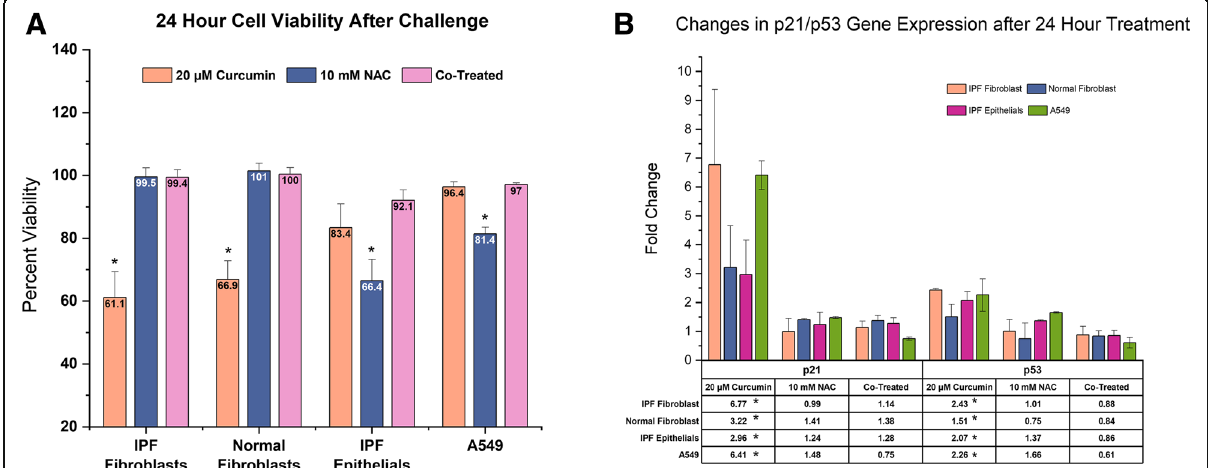
Fig. 5 Epithelial and fibroblast cell viability and DNA damage response gene expression after 24-h challenge: ( a ) 20 μ M curcumin treatment induces reduced viability in IPF-F ( n = 4) and NHLF ( n = 3) with significant effect on IPF epithelial cells (IPF-E n = 3) or A549 epithelial cells (n = 3). 10 mM NAC treatment induces reduced viability in epithelial cells but no significant effect in fibroblasts. Combination 10 mM NAC and 40 μ M curcumin does not induce any change in cell viability as compared to untreated controls. ( b ) 20 μ M curcumin induces significant increases in gene expression of p53 and p21 in all cell types. 10 mM NAC alone and in combination with 40 μ M curcumin does not result in significant change to this gene expression in either epithelial or fibroblast cell lines. * indicates p value <